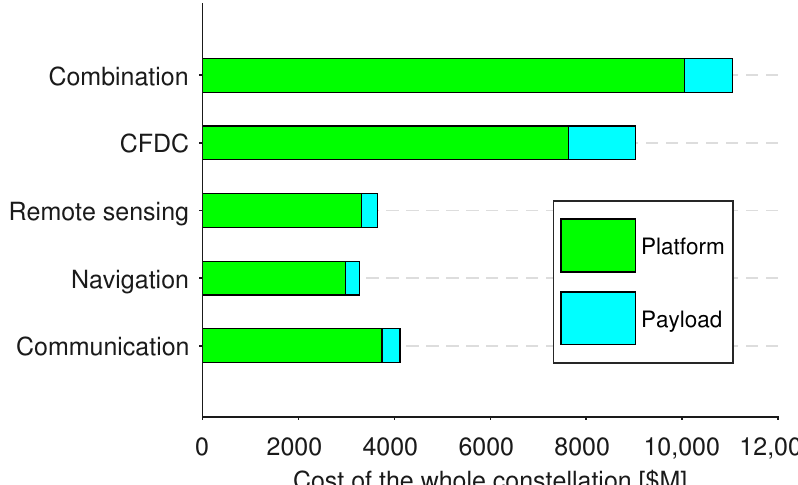
Figure 7. Constellation